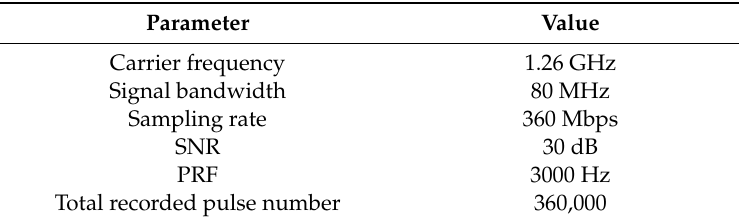
Table 1. Experimental parameters.